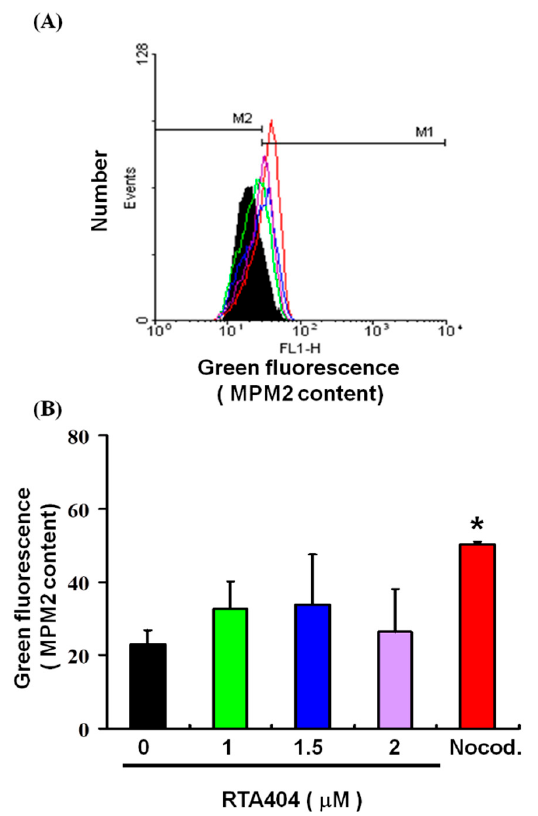
Figure 5. Mitotic index was assessed based on MPM-2 expression. Flow cytometry analysis of MPM-2 expression in the treated cells was conducted. ( A ) Cells were either treated or not treated with 0, 1, 1.5, or 2 μ M RTA404. After 24 h of treatment, cells were fixed with 70% ethanol, stained with MPM-2 and PI, and analyzed using FACScan software. ( B ) Results are expressed as a percentage of the control, with the control being 100%. All data are reported as means ± standard errors of the mean on the basis of the results of at least three separate experiments. Statistical analysis was performed using the t test, with differences between the treatment and control groups con- sidered significant at p < 0.05, as denoted by *.